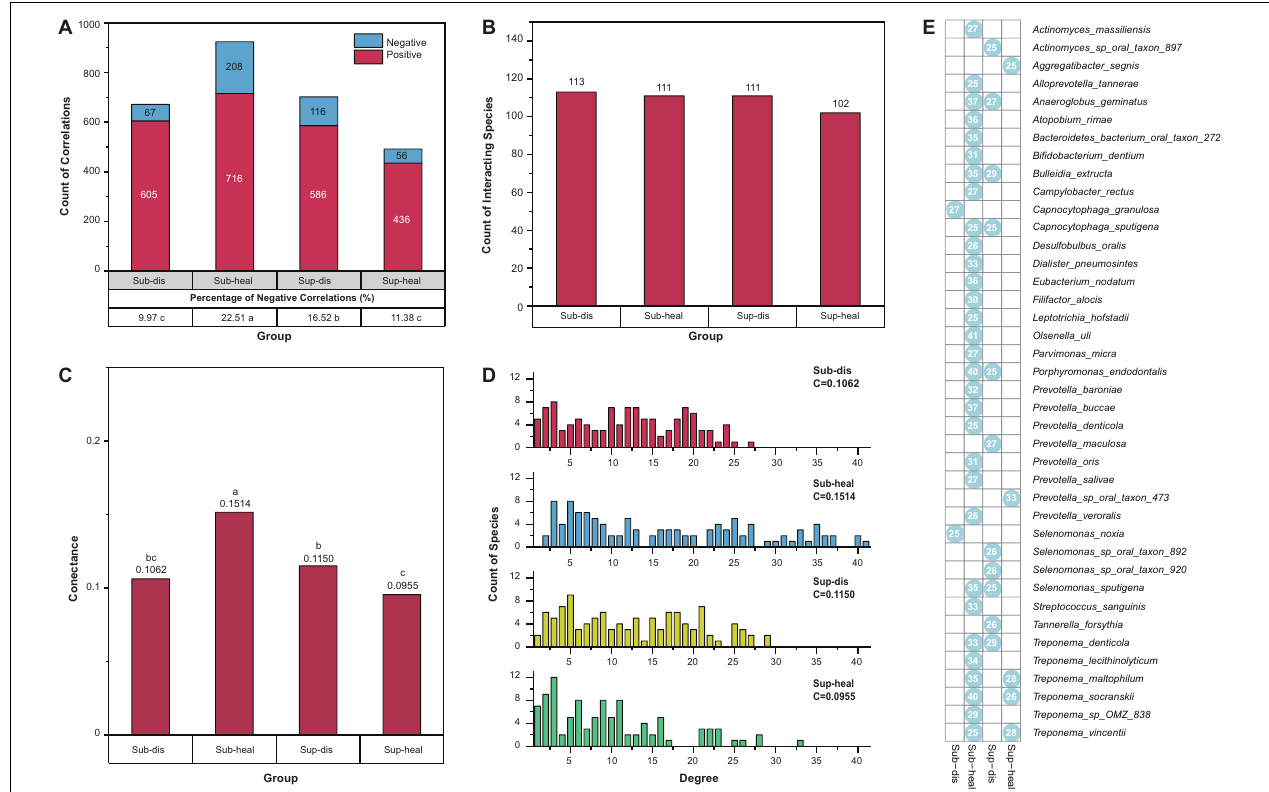
FIGURE 3 | Properties of the community structures in different microbiomes. (A) Positive and negative correlations were shown in red and blue, respectively. Positive correlations were predominant in all communities. The percentage of negative correlations in diseased subgingival communities was significantly lower than that in healthy subgingival communities. However, such difference was reversed between diseased and healthy supragingival communities ( p < 0.05, Pearson chi-square). (B) All communities in our study had similar counts of interacting species ( p > 0.05, Pearson chi-square). (C) When associated with periodontitis and peri-implantitis, the subgingival community exhibited a decrease in connectance while the supragingival community exhibited an increase in connectance. Significance of differences was marked in letters. (D) Degree distributions of the diseased subgingival, healthy subgingival, diseased supragingival, and healthy supragingival networks are shown in red, blue, yellow, and green bars, respectively. C stood for connectance. A conspicuous difference was observed in the degree distribution of healthy subgingival communities as there were significantly more high-degree (degree > 25) species ( p < 0.05 Pearson chi-square). (E) Hub species in the diseased subgingival, healthy subgingival, diseased supragingival, and healthy supragingival microbiome are shown in the heatmap. A blue dot means the species had more than 25 interspecies correlations in the corresponding microbiome. Numbers within the dots showed the counts of correlations of the